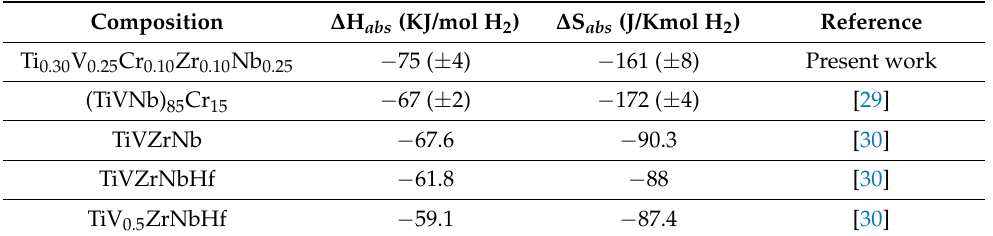
Table 3. V 0.25 Cr 0.10 Zr 0.10 Nb 0.25 alloy absorbs hydrogen in two steps forming a dihydride phase at max- maximum capacity. imum capacity. Composition